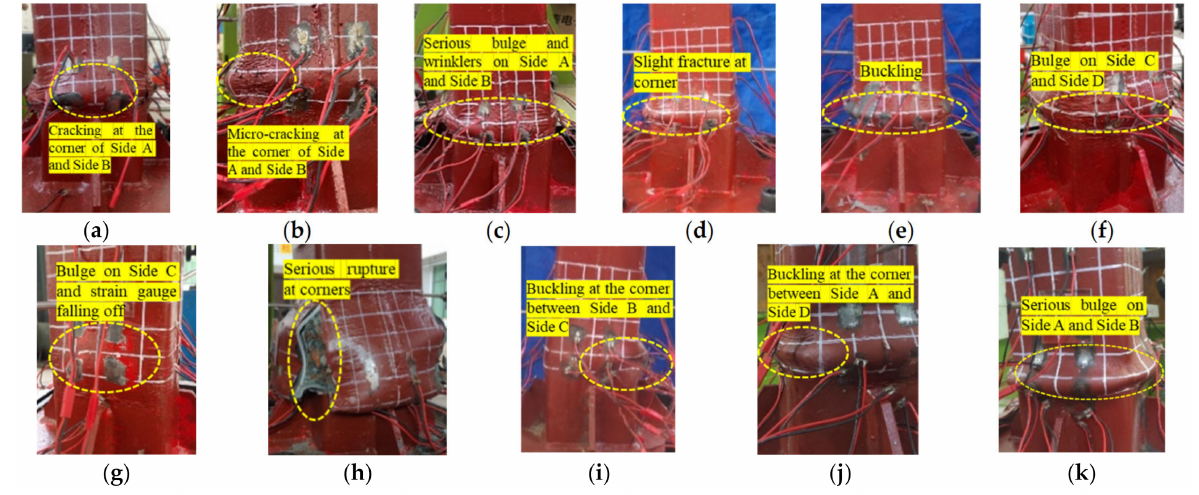
Figure 7. ( a ) Typical local failure of specimens for STG4-0-0.25; ( b ) typical local failure of specimens for STG4-0.3-0.25; ( c ) typical local failure of specimens for STG4-0.5-0.25; ( d ) typical local failure of specimens for STG4-0.7-0.25; ( e ) typical local failure of specimens for STG4-1-0.25; ( f ) typical local failure of specimens for STG6-0.5-0.25; ( g ) typical local failure of specimens for STG4-0.5-0.05; ( h ) typical local failure of specimens for STG4-0.5-0.5; ( i ) typical local failure of specimens for STM4-0- 0.25; ( j ) typical local failure of specimens for STM4-0.5-0.25; ( k ) typical local failure of specimens for